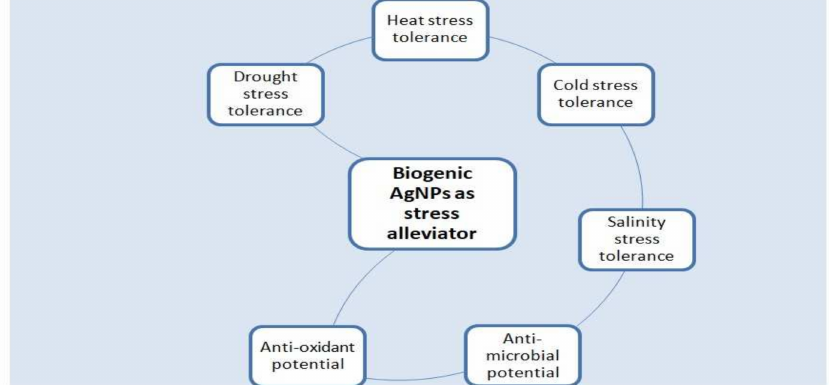
Figure 6. Plant-mediated AgNPs as a stress alleviator against agricultural